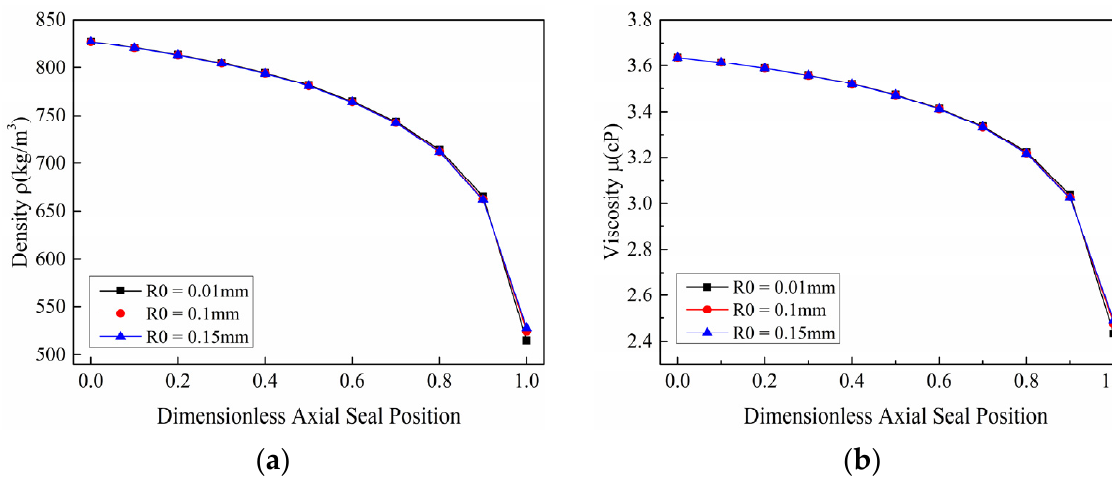
Figure 10. Mixture properties’ changes along the axial direction of the model seal under different bubble radii for ∆ P = 48.3 bars. ( a ) Density changes, ( b ) viscosity changes. Figure 11 compares the variation of the seal leakage with inlet GVF but under bubble radii of 0.01, 0.1, and 0.15 mm, respectively. The comparisons show that increasing